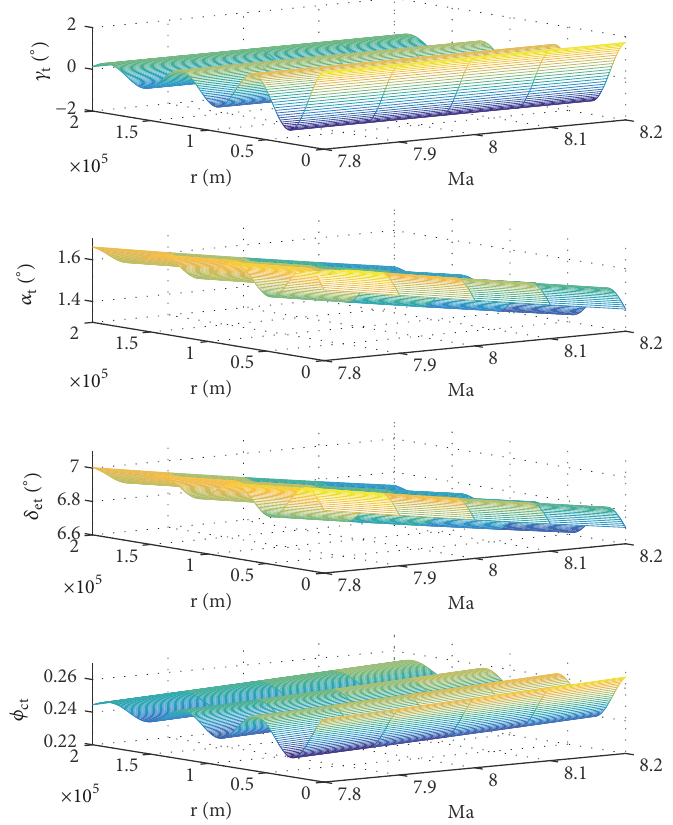
Figure 7: Change surfaces of dynamic balance states with regard to 𝑀𝑎 = 7.8 − 8.2 and 𝑟 = 0𝑘𝑚 − 20𝑘𝑚